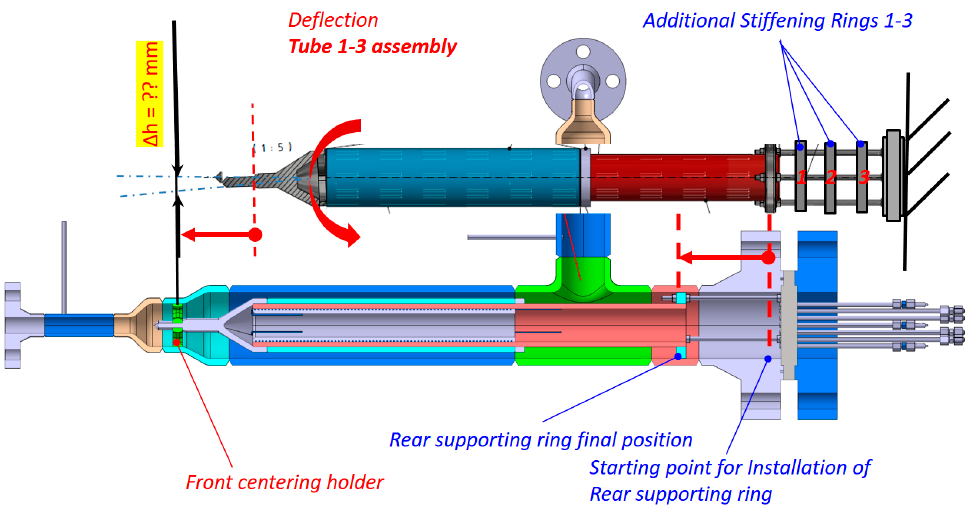
Figure 17. Assembly of the tube insert.